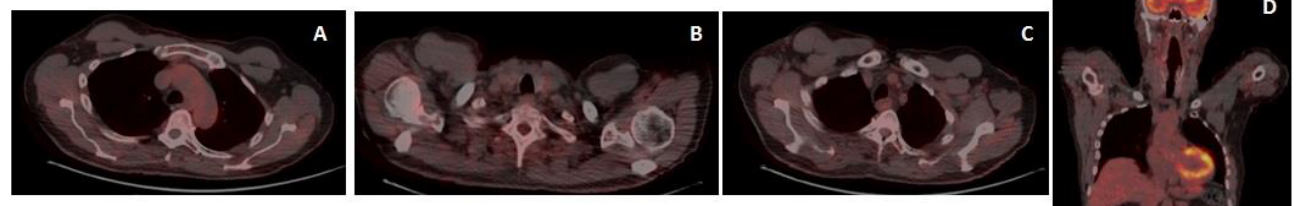
Figure 6. Restaging 18-FDG-PET/CT after chemotherapy showed the complete metabolic response of all the involved sites ( A – D